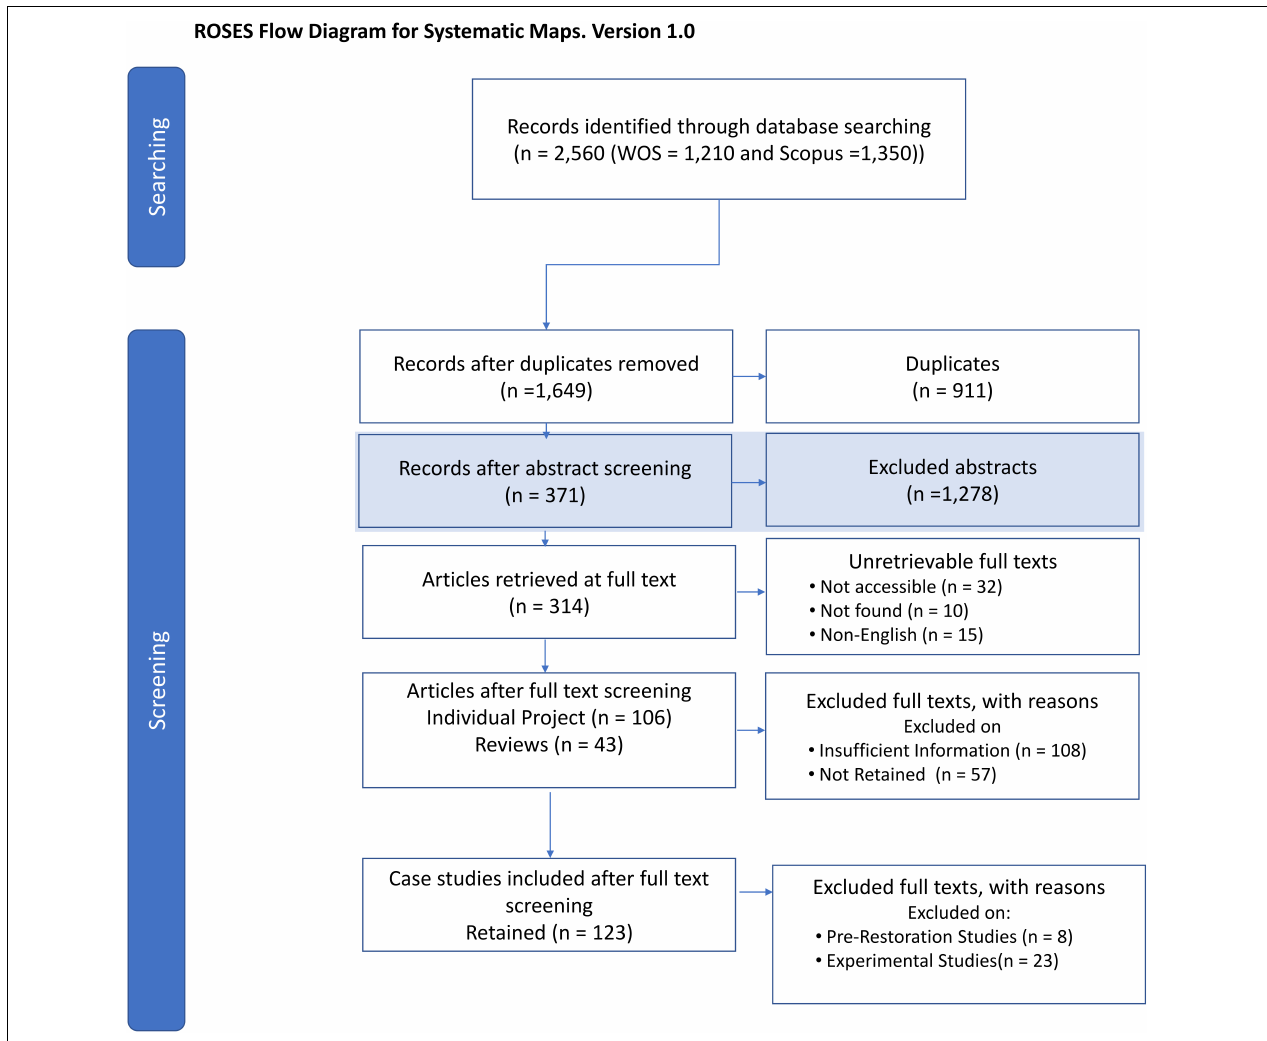
FIGURE 1 | ROSES flow diagram of the literature breakdown through